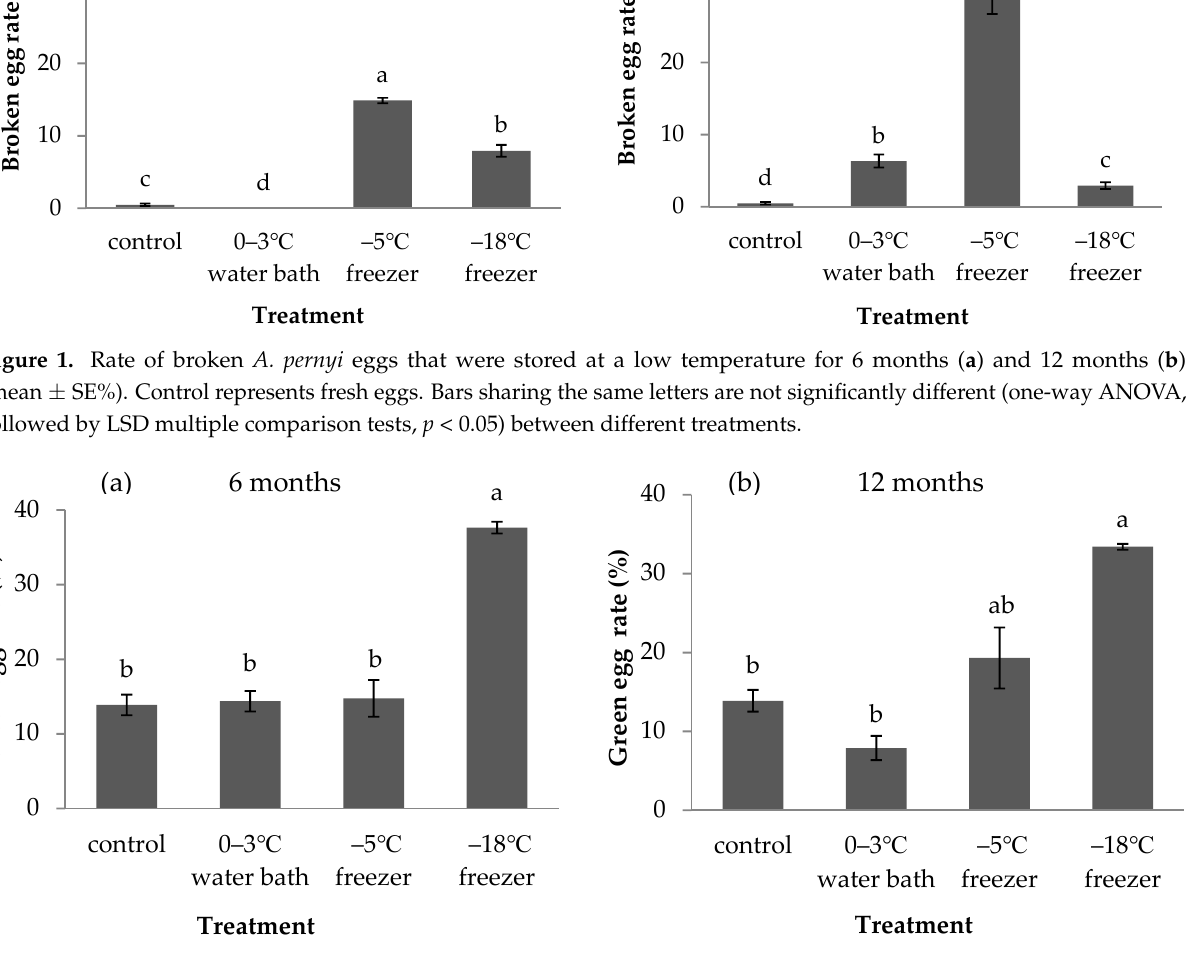
Figure 2. Rate of green eggs of A. pernyi eggs that were stored at low temperature for 6 months ( a ) and 12 months ( b ) (mean ± SE%). Control represents fresh eggs. Bars sharing the same letters are not significantly different ( a : one-way ANOVA, followed by LSD multiple comparison tests, p < 0.05; b : one-way ANOVA, followed by Games–Howell multiple comparison tests, p < 0.05) between different treatments.